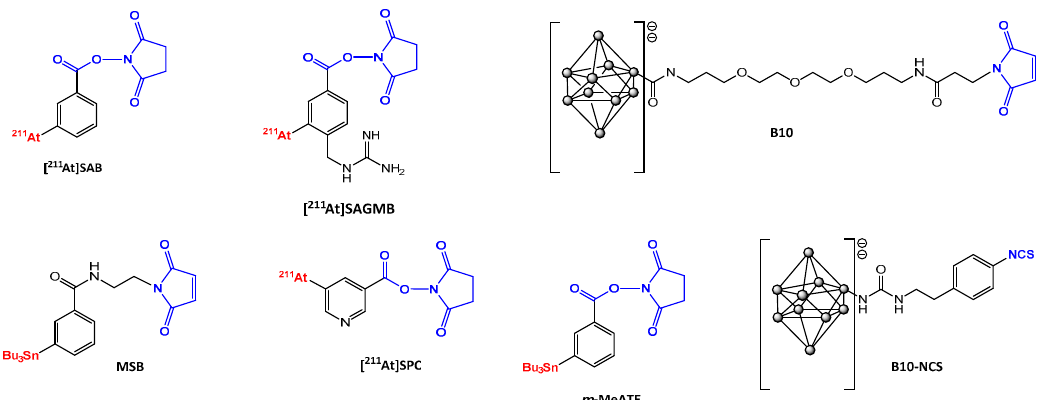
Figure 4. Structures of main prosthetic groups used for 211 At radiolabeling. [ 211 At]SAB: N -succinimidyl-3-[ 211 At]astatobenzoate [111,113]; [ 211 At]SAGMB: N -succinimidyl 3-[ 211 At]astato-4-guanidinomethyl benzoate [123]; B10: maleimido- closo -decaborate(2-) derivative [110]; MSB: N -2-(maleimido)ethyl-3-(trimethylstannyl)benzamide [115]; [ 211 At]SPC: N -succinimidyl 5-[ 211 At]astato-3-pyridinecarboxylate [127]; m -MeATE: N -succinimidyl-3-(trimethylstannyl)-benzoate [114]; B10-NCS: isothiocyanatophenyl- closo -decaborate(2-) derivative [110].